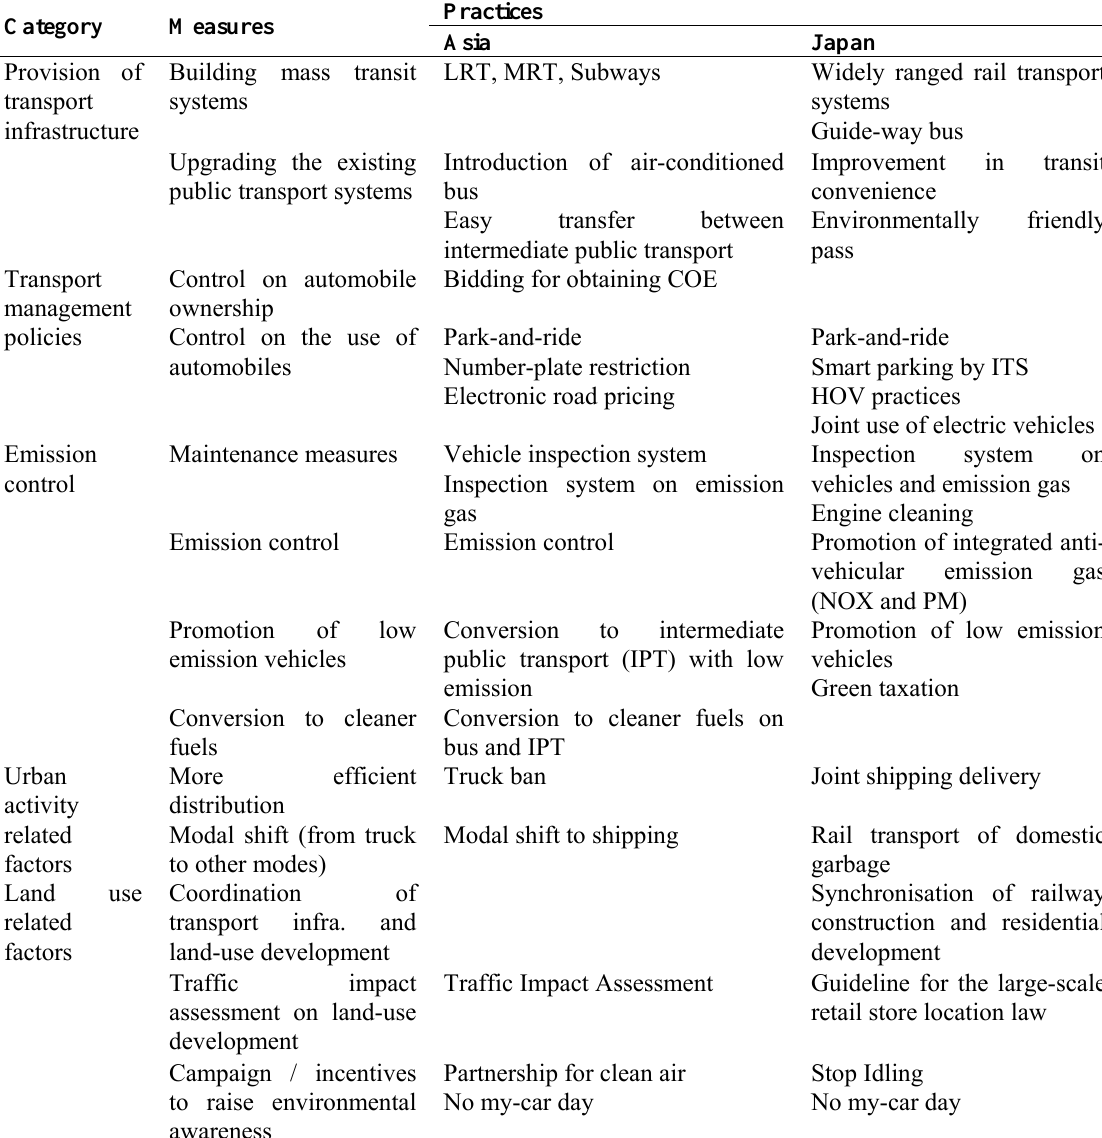
Table 2. Summary of various practices in